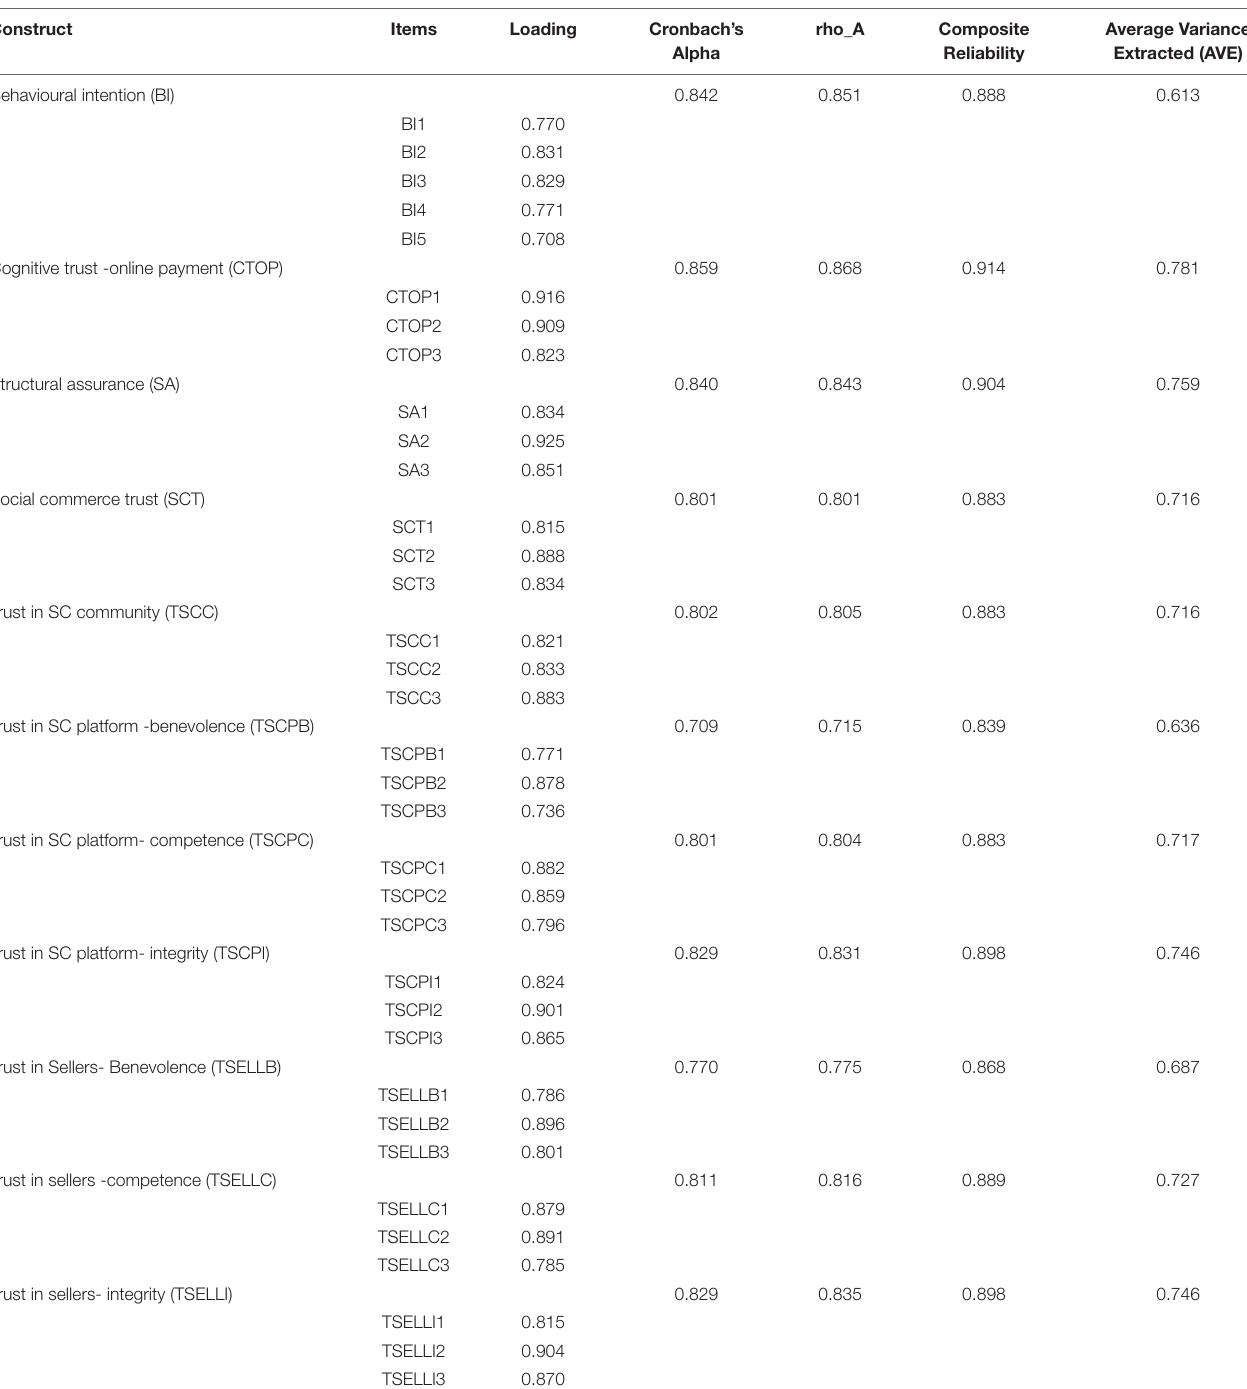
TABLE 2 | First-order construct